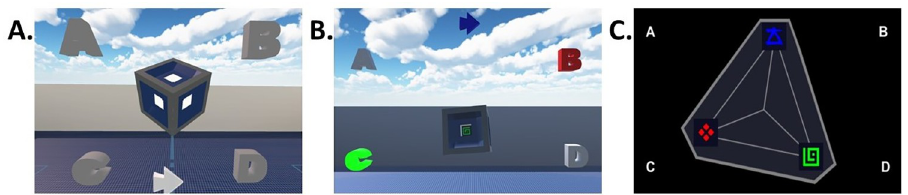
Fig 4. The participants’ view in the VR, 3D, and 2D conditions. (A) An example screenshot of the view for participants in the VR condition. Specifically, this showcases the participant’s view at the beginning of each trial. No stimulus features are visible. (B) An example screenshot from the 3D condition showing the participant’s point of view during the feedback phase. Participant’s choice shown in red, correct answer shown in green. Participant’s choice lights up in green if they answered correctly. (C) The 2D stimulus as presented to the 2D group. Symbols and category structure are the same across all three